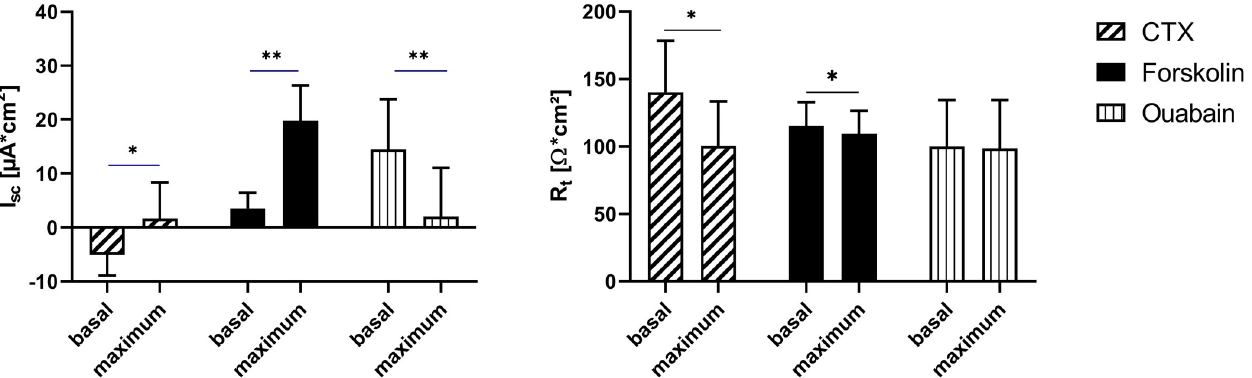
Fig 9. Basal and maximal I sc and R t values of organoid-based 2D monolayers cultivated for 18 days determined before and after subsequent addition of CTX, forskolin and ouabain. Values shown are the mean ± SD of four independent experiments. � p < 0.05; �� p < 0.01.